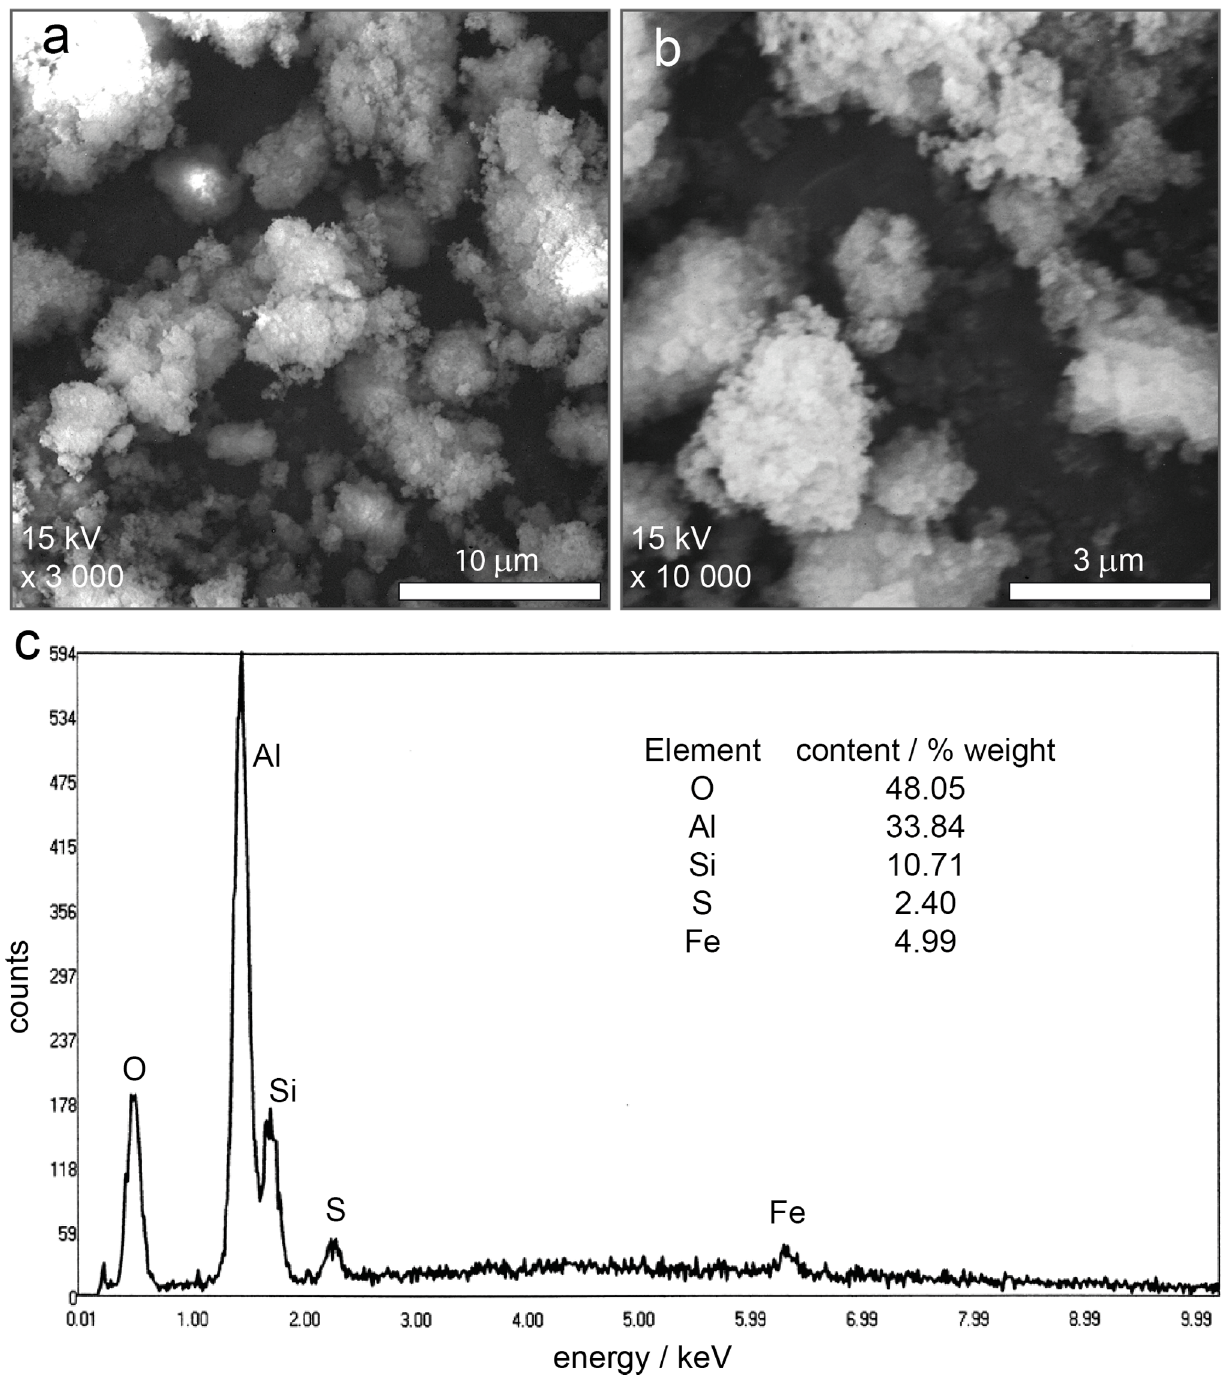
Figure 2. SEM-EDS analysis of Rı´o Celeste sediments. ( a ) and ( b ) SEM micrographs to 10 m m (15kV 6 3,000) and 3 m m (15kV 6 10,000) respectively of the pale yellow powder sedimented at the bottom of Rı´o Celeste. Micrographs indicate that the material is formed by an agglomeration of smaller particles deposited successively at the bottom river. ( c ) EDS analysis of the pale yellow powder showed that it is composed mainly of aluminium, silicon and oxygen. Other species such as iron and sulfur were also found in the sediment in minor proportions.